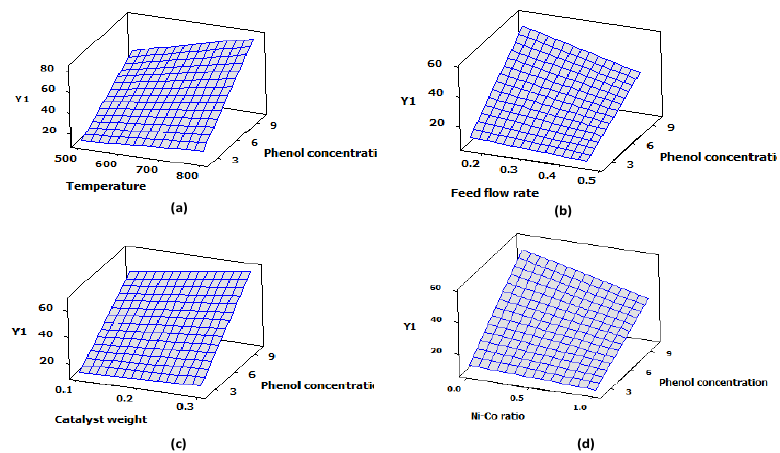
Figure 11. Surface plot for significant interactions on Y 1 : ( a ) AE ; ( b ) BE ; ( c ) CE ; ( d ) DE .